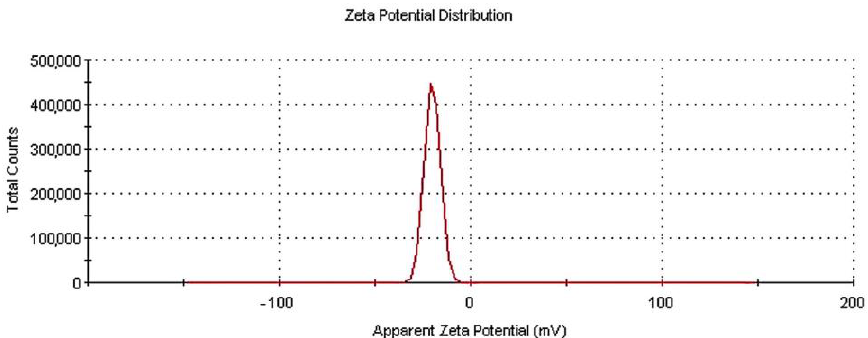
Figure 3. Zeta potential distribution for N-TiO 2 particles in water dispersion.